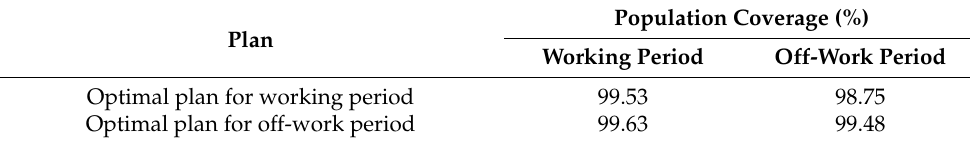
Table 2. Population coverage of Shenzhen.